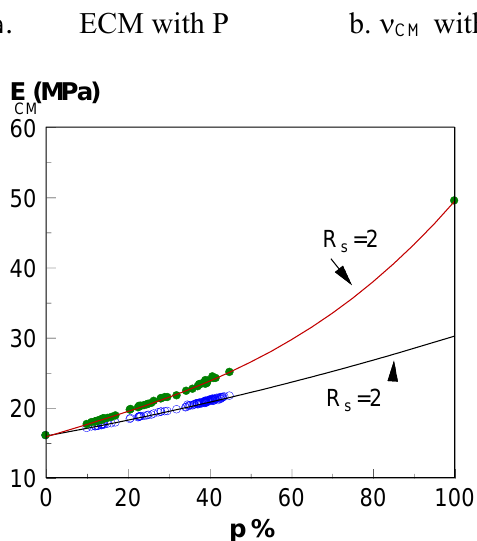
Fig. 7. The variation of CM properties with p. Figure 7: The variation of CM properties with